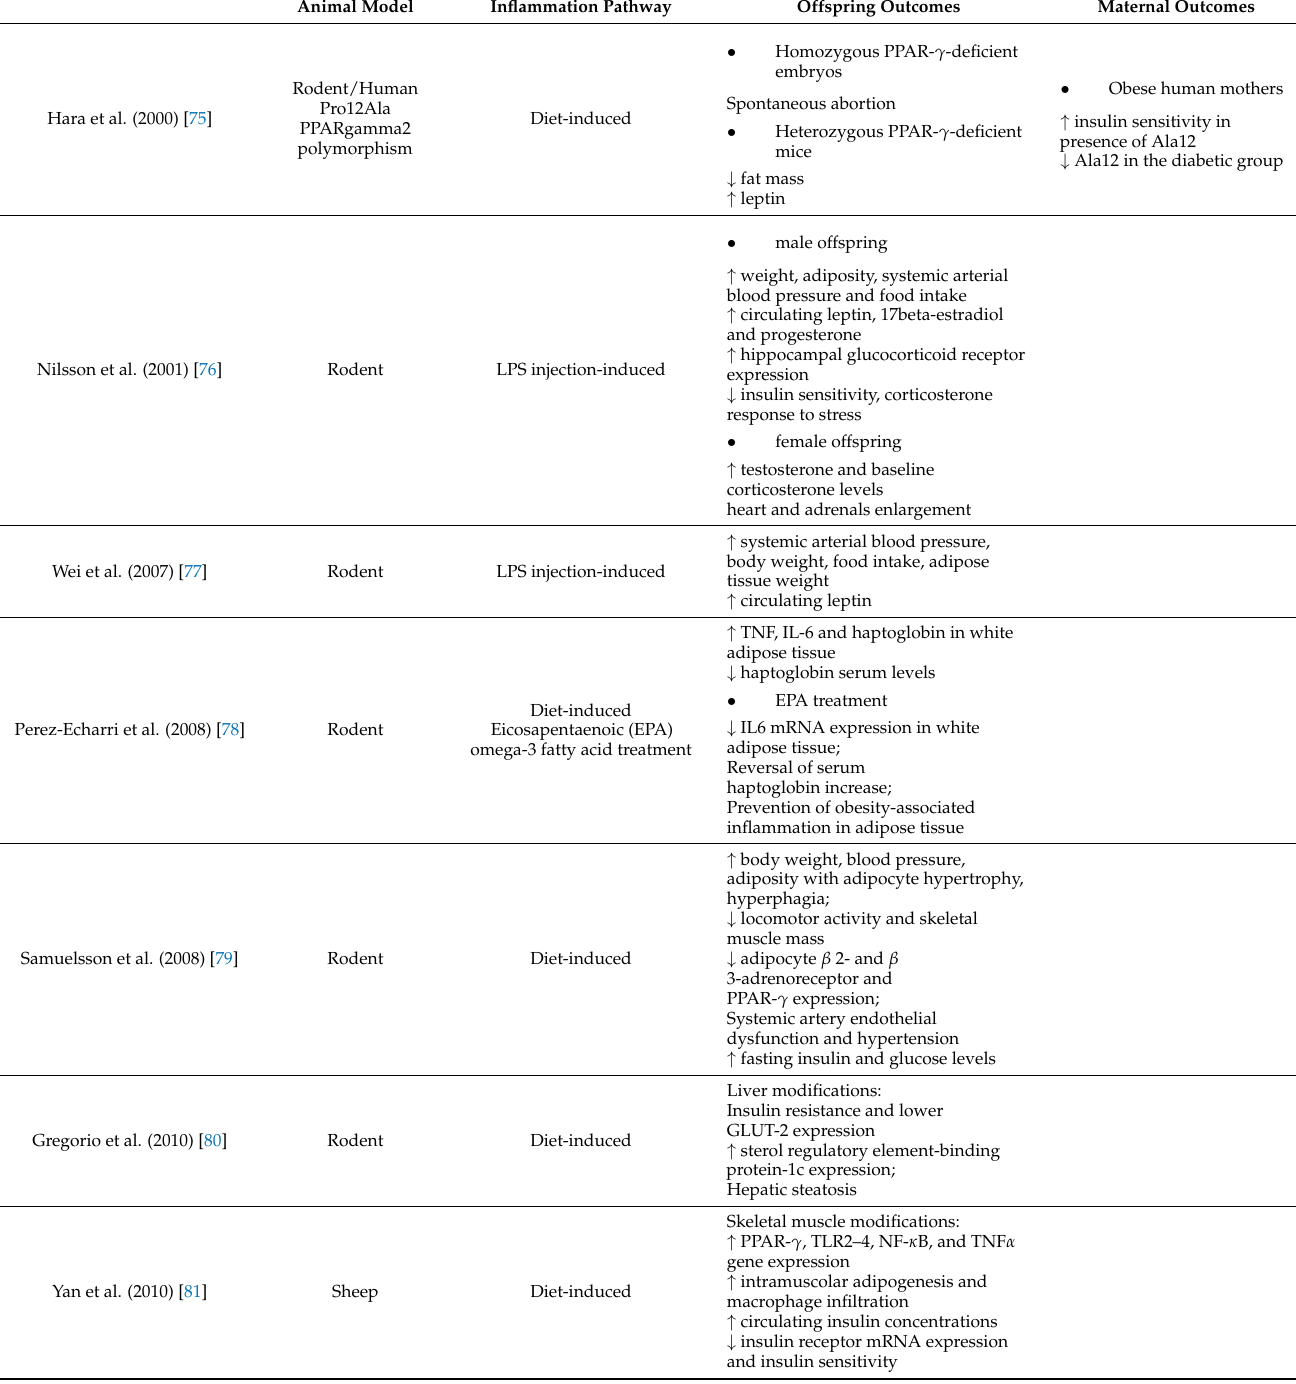
Table 1. Animal models of obesity-related maternal inflammation and offspring outcomes. PPAR- γ : peroxisome proliferator- activated receptor gamma; TNF: tumor necrosis factor; TLR: toll-like receptor; NF- κ B: nuclear factor kappa-light-chain- enhancer of activated B cells; GLUT: glucose trasporter; G3PDH: glyceraldehyde-3-phosphate dehydrogenase; IL: interleukin; FGR: fetal growth restriction. “ ↑ ” means increase; “ ↓ ” means